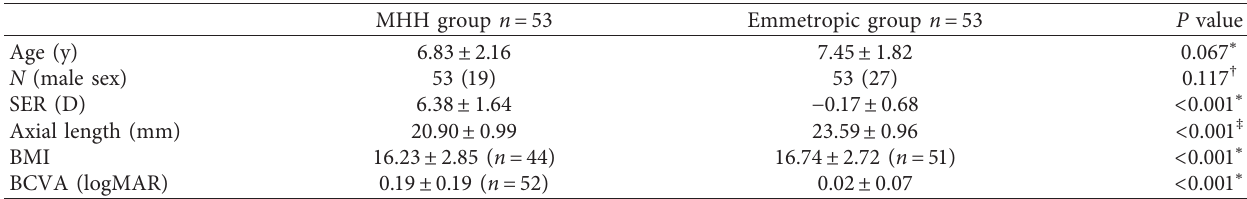
Table 1: Descriptive and ocular parameters of the MHH and emmetropic